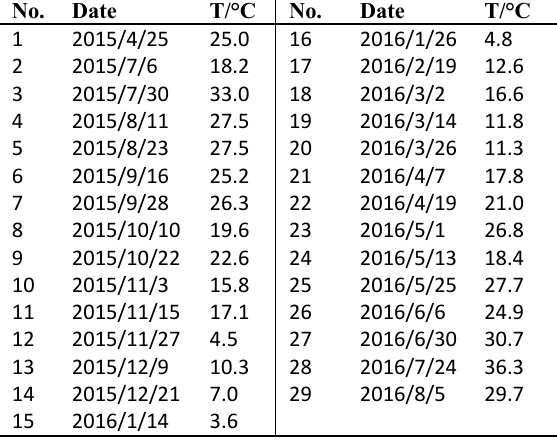
Table 1: Sentinel-1A dataset covering the Dashengguan Yangtze River Bridge